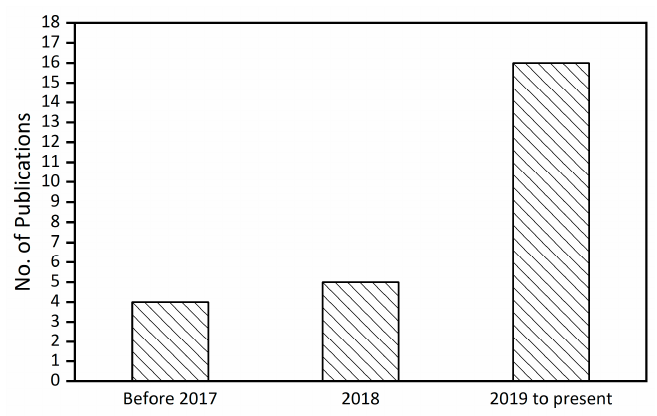
Figure 1. Number of publications on welding of high entropy alloys over time.